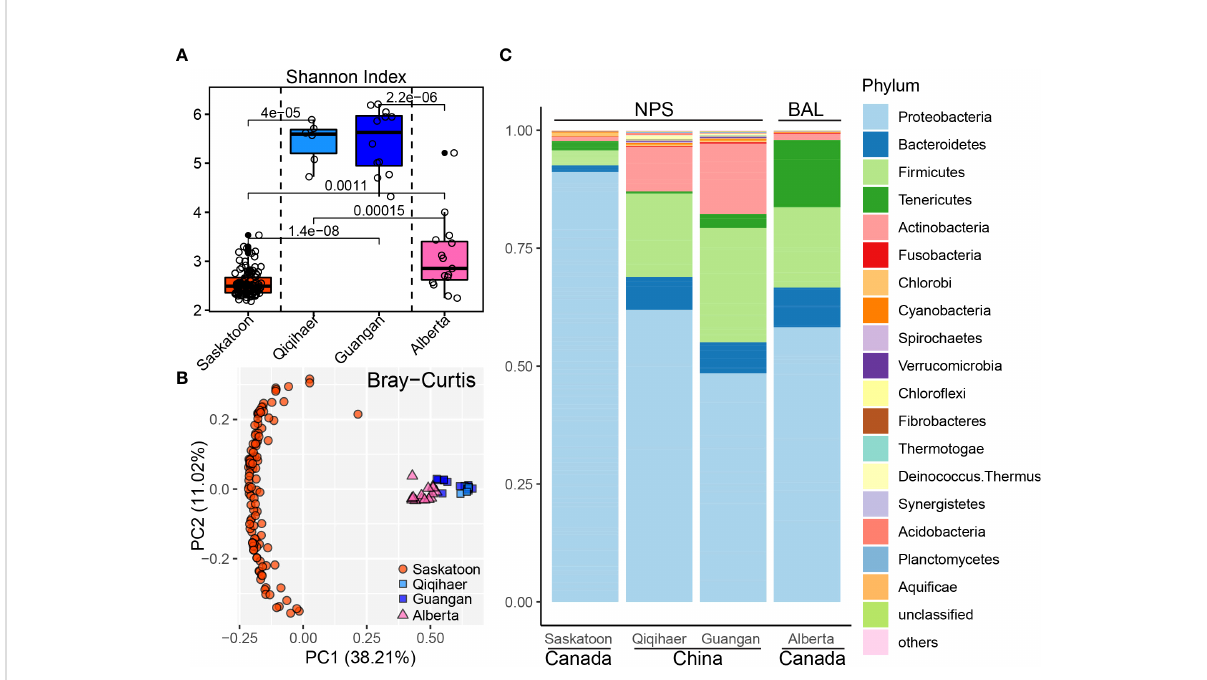
FIGURE 1 Bovine respiratory microbiome in fl uenced by geographic locations and sampling niches. (A) Shannon index of bovine respiratory microbiota among NPS of Saskatoon (Canada), NPS of Qiqihaer and Guangan (China), and BAL of Alberta (Canada). Alpha diversity was tested using the Kruskal – Wallis test. The line inside the box denotes the median, and the boxes denote the interquartile range between the fi rst and third quartiles (25th and 75th percentiles, respectively). (B) Principal coordinate analysis of the Bray – Curtis distances between microbiota. (C) Bacterial abundances at the phylum level. NPS, nasopharyngeal swab; BAL, bronchoalveolar